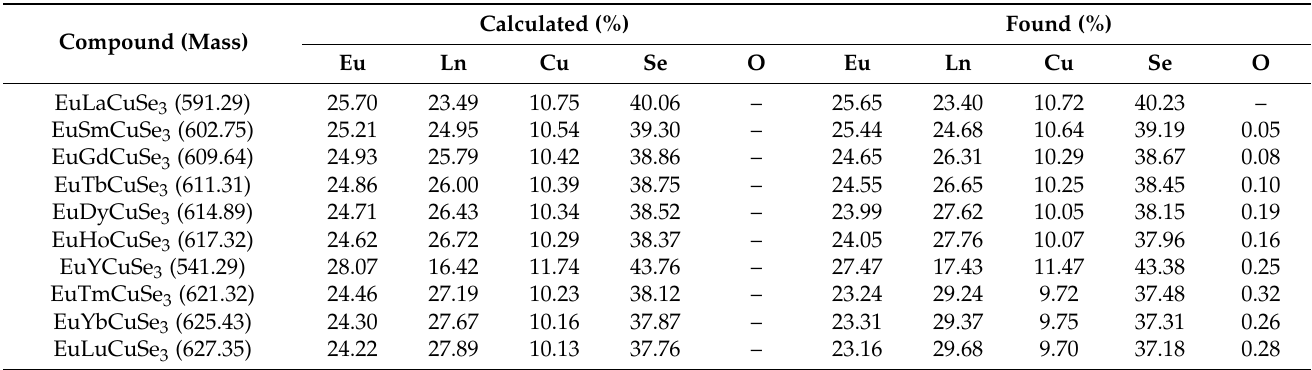
Table 6. The calculated and found elemental analysis data for the reported selenides obtained using